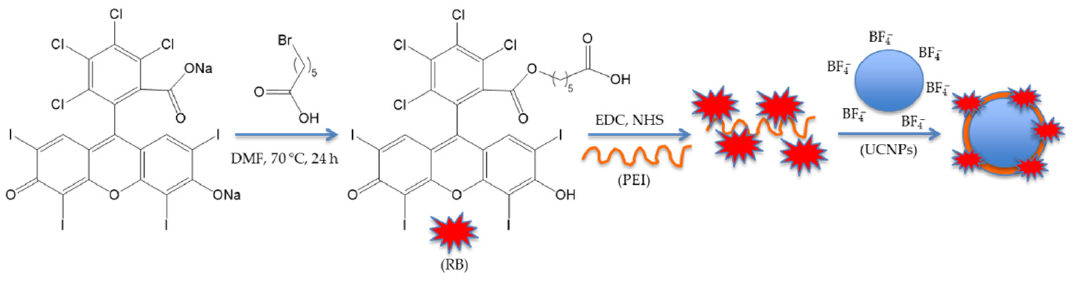
Figure 6. Covalent coupling of RB onto Er@Nd UCNPs. Adapted from Li et al. [25]. 1 O 2 production occurred as a result of the energy transfer from Nd 3+ to Yb 3+ to Er 3+ to RB. The UCNPs had a size of 25.7 ± 1.4 nm, with a shell thickness of about 6 nm. In vitro tests on 4T1 cells showed the production of 1 O 2 by means of DPBF. The amount of 1 O 2 produced increased with increasing irradiation time (maximum 8